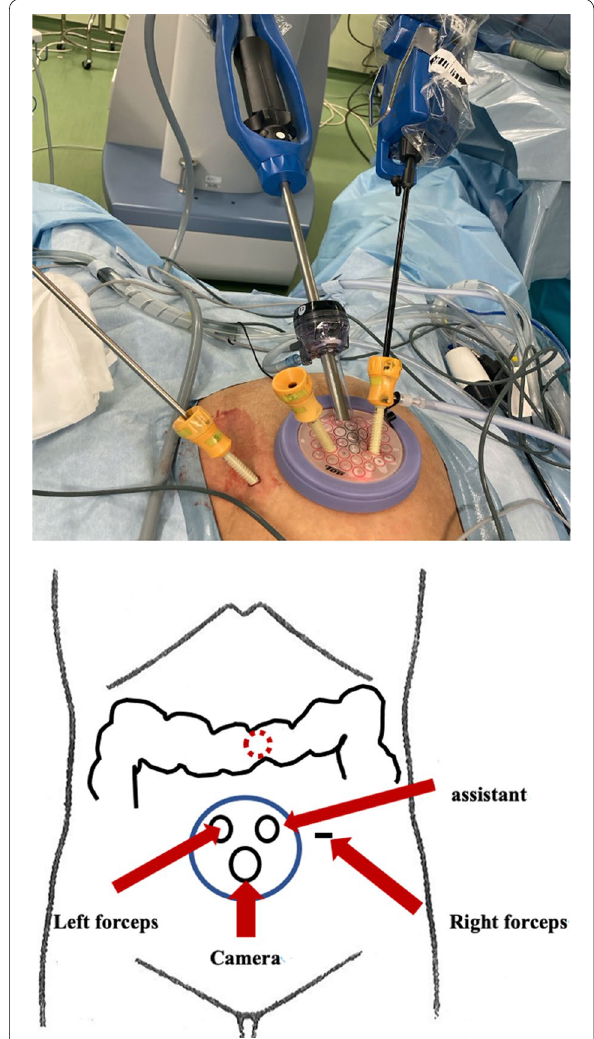
Fig. 2 Positional relationship between forceps and lesions. Tumor location was verified as mid-transverse colon. The camera and forceps were inserted as shown in the above figure